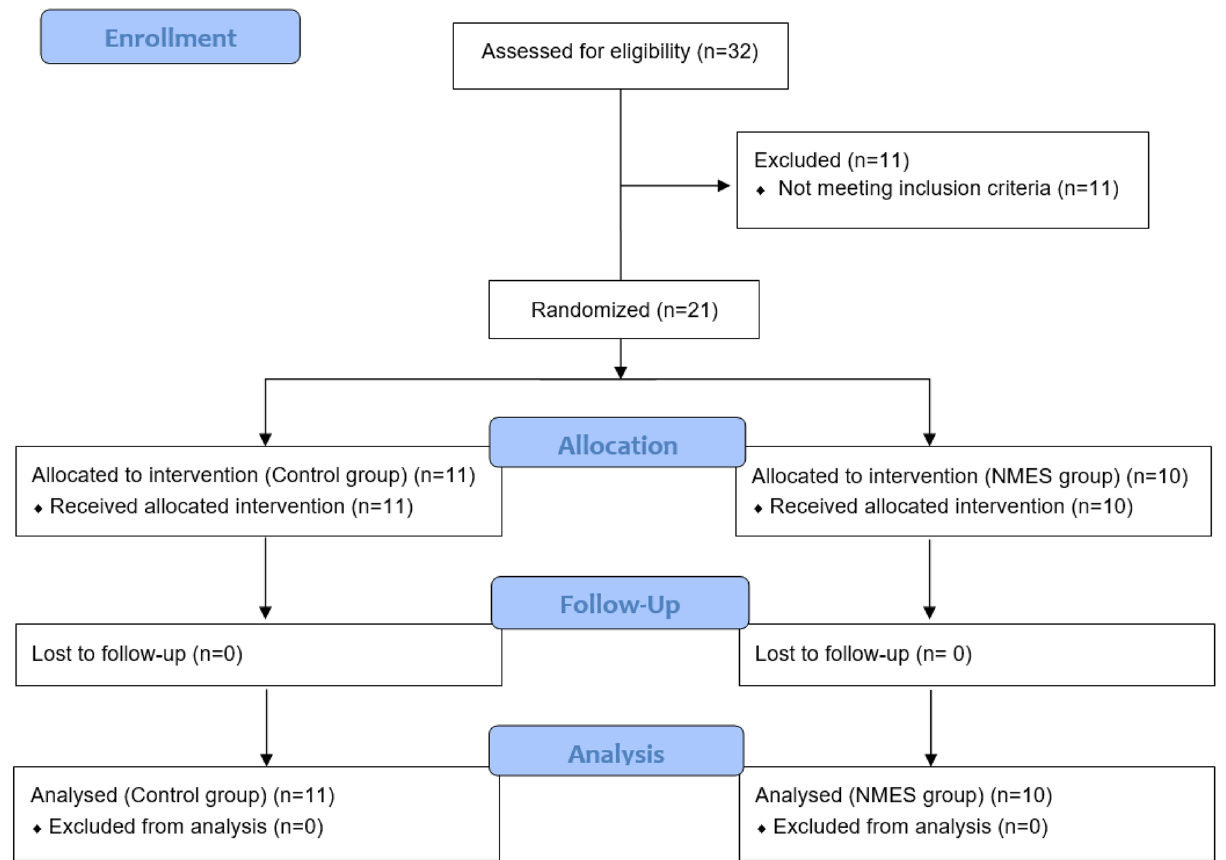
Figure 1. Consort flowchart. NMES Neuromuscular electrical